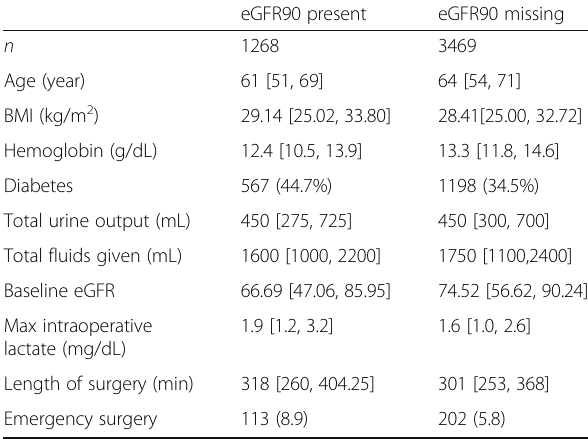
Table 1 Patient and surgical characteristics stratified by whether the patient record contained a record of eGFR at 90 days postoperatively. Continuous variables are reported as median (IQR) and binary variables are reported as proportion (%) eGFR90